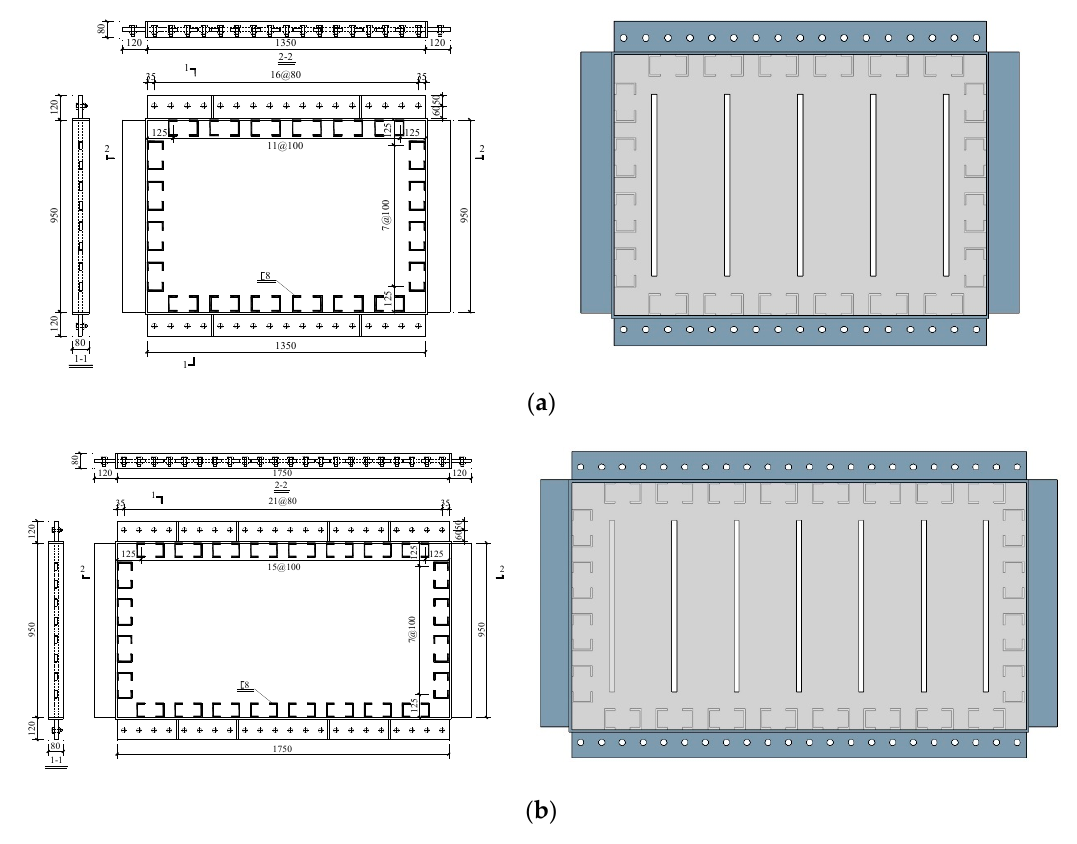
Figure 1. General description of test specimens: ( a ) RCIP-1–3 and ( b ) RCIP-4 (dimensions in mm). RCIP-1 and RCIP-4 had penetrated slits, and the width of each slit was 20 mm. Two types of concealed slits were introduced in RCIP-2 and RCIP-3. RCIP-2 had CVSs, where the width of each CVS was 20 mm, and the unpenetrated concrete thickness was 30 mm. RCIP-3 had CHSs, where the thickness of the unpenetrated concrete at the outer parts was 40 mm, and its width was also 20 mm. The foam board was introduced to develop the CHSs in the RC panel. The height of each slit wall was 660 mm, and the panel thickness of each specimen was 80 mm. The slit wall widths of RCIP-1–3 at the central region and both ends were 245 and 135 mm, respectively. The corresponding widths of the slit walls of RCIP-4 were 220 and 145 mm, respectively. Six 6.5 mm in diameter, smooth, mild lon- gitudinal rebars were embedded in the 245 and 220 mm separate slit walls, and the corre- sponding steel rebar ratios were approximately 1.01% and 1.13%, respectively. The longi- tudinal rebars at the top and bottom solid wall parts were anchored completely. The con- fining reinforcement cages were arranged around the RC panel perimeter to prevent the splitting of the shear connectors in the panel thickness direction. Smooth steel-wire two- legged closed stirrups of 4 mm in diameter spaced at 50 mm were placed in the slit walls and surrounding reinforcement cages. Figure 2 shows the dimensions and reinforcement details of the RC panels.